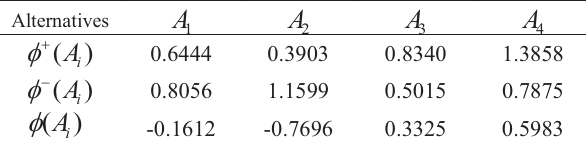
Table 15. The leaving, entering and net